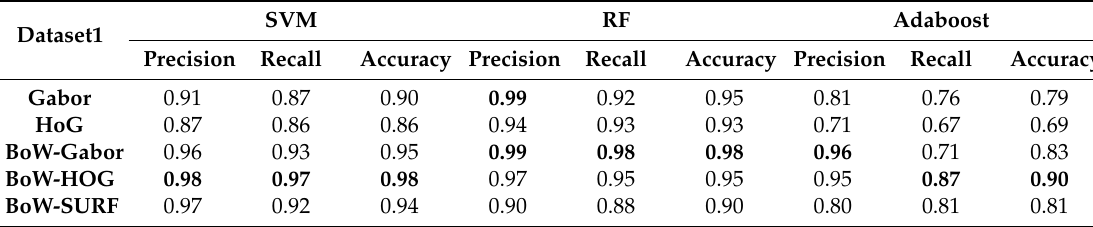
Figure 4. Samples of image patches in dataset 1—UAV images. Table 3. Performance of feature descriptors when associated with different learning algorithms for dataset 1 comprising patches from the UAV images (training samples = 676, testing samples = 290)—bold numbers indicate best performance per indicator.